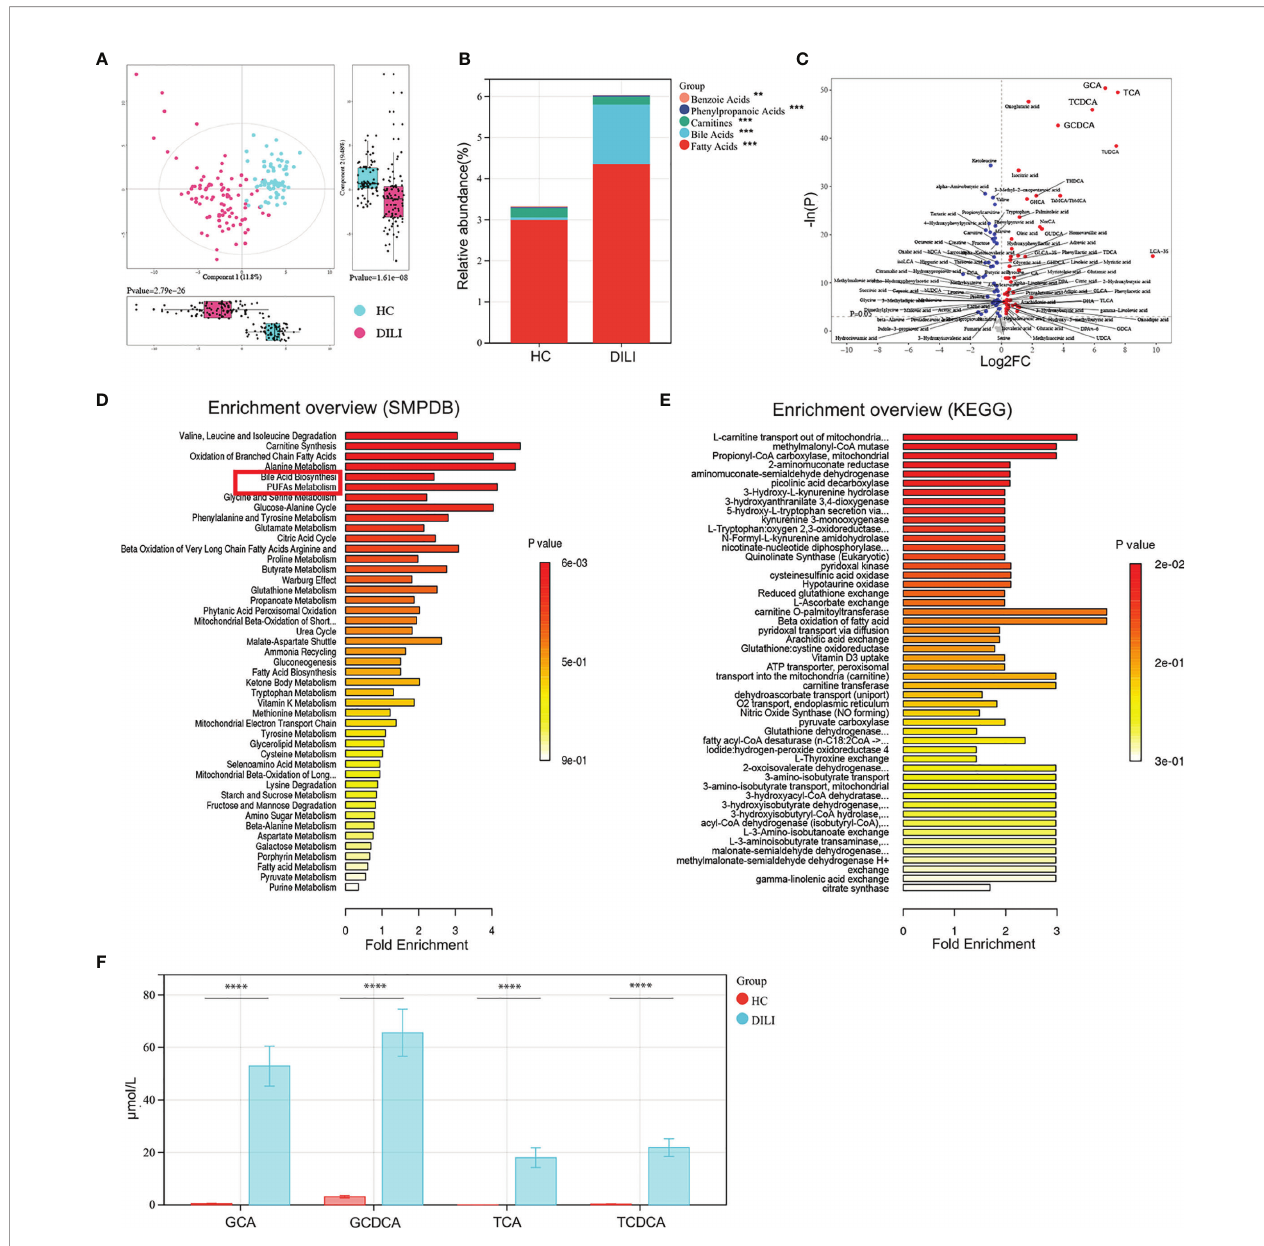
FIGURE 2 | Examination of the metabolic pro fi les of HCs and DILI patients. (A) The PCA plot showed a clear discrimination of serum metabolic pro fi les between DILI patients and HCs. (B) The relative abundance of mainly differential metabolite classes in HC and DILI group. (C) Volcano plot of the most signi fi cant metabolite changes comparing HCs with DILI patients. (D, E) Pathway analysis used to discover the differences of metabolic characteristics between DILI and HCs (based on KEGG or SMPDB). (F) Boxplot of the four most signi fi cant metabolites in the analysis of volcano plot comparing HCs and DILI patients. **p < 0.01; ***p < 0.001; ****p < 0.0001. PCA, principal component analysis; PUFA, polyunsaturated fatty acid; SMPDB, human metabolome database; KEGG, kyoto encyclopedia of genes and genomes; GCA, glycocholic acid; GCDCA, glycochenodeoxycholic acid; TCA, taurocholic acid; TCDCA, taurochenodeoxycholic